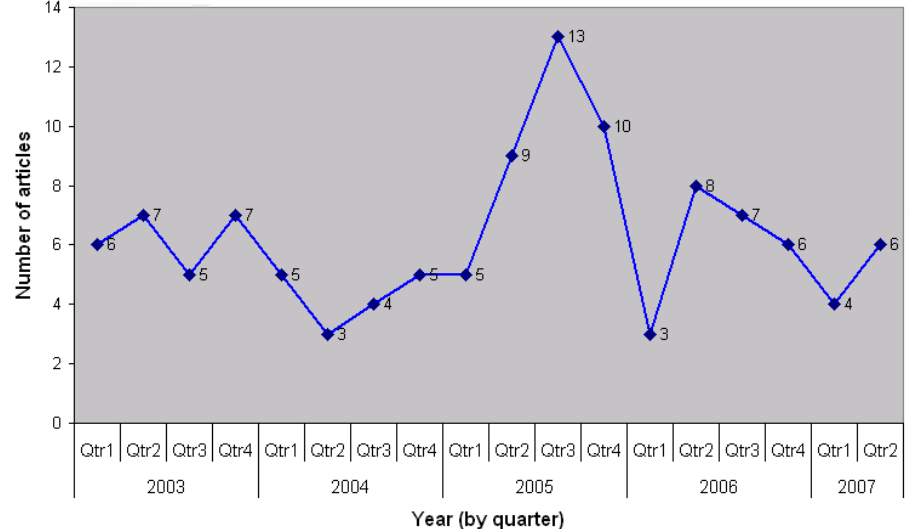
Figure 1. Count of articles over study period.